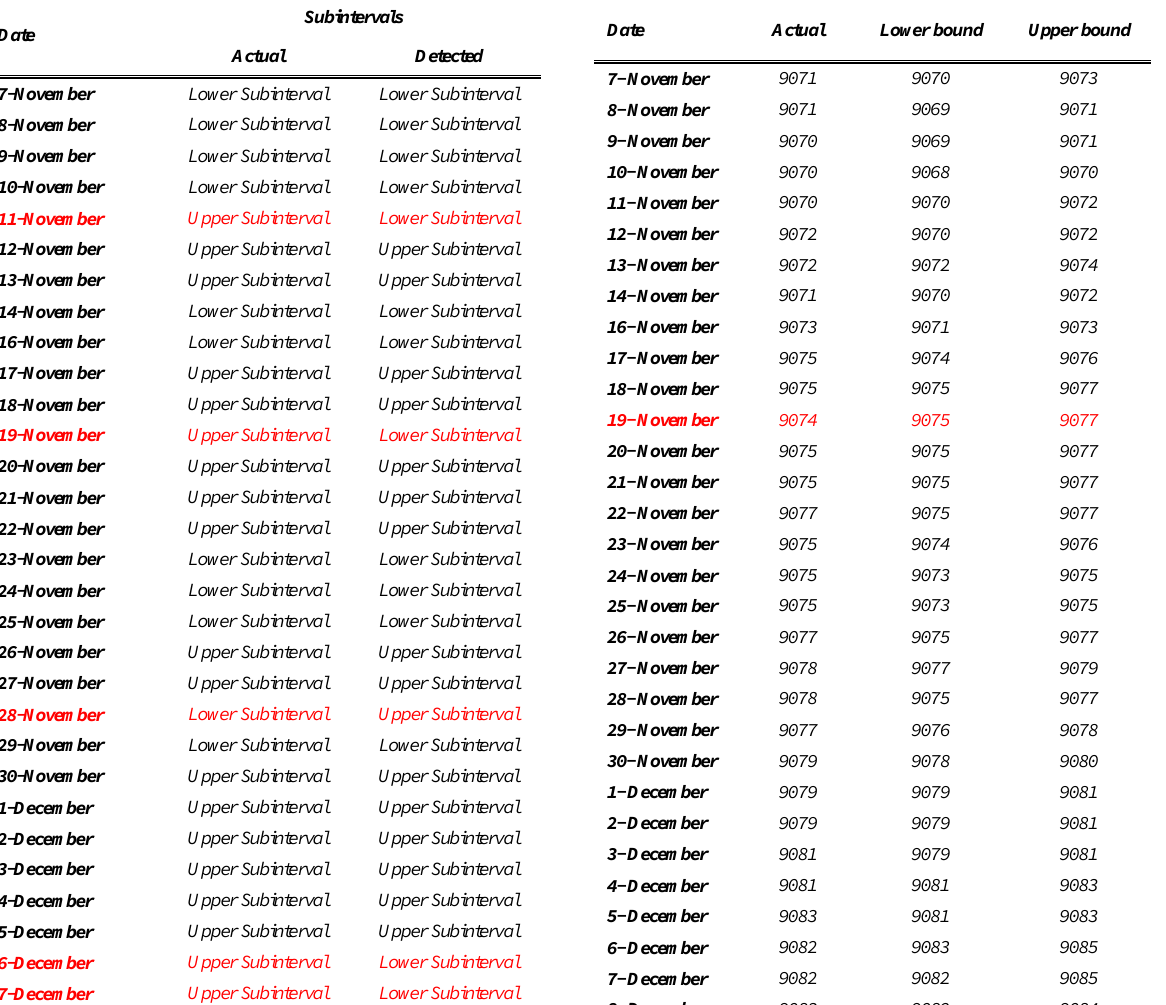
Table 2. Detected subintervals for actual values in the forecasted interval by FARIMA for training data set.